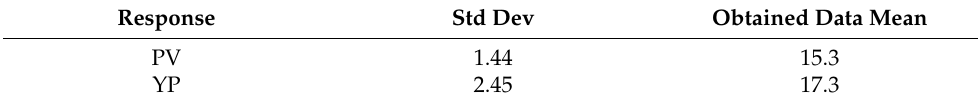
Table 9. Confirmation of Model.